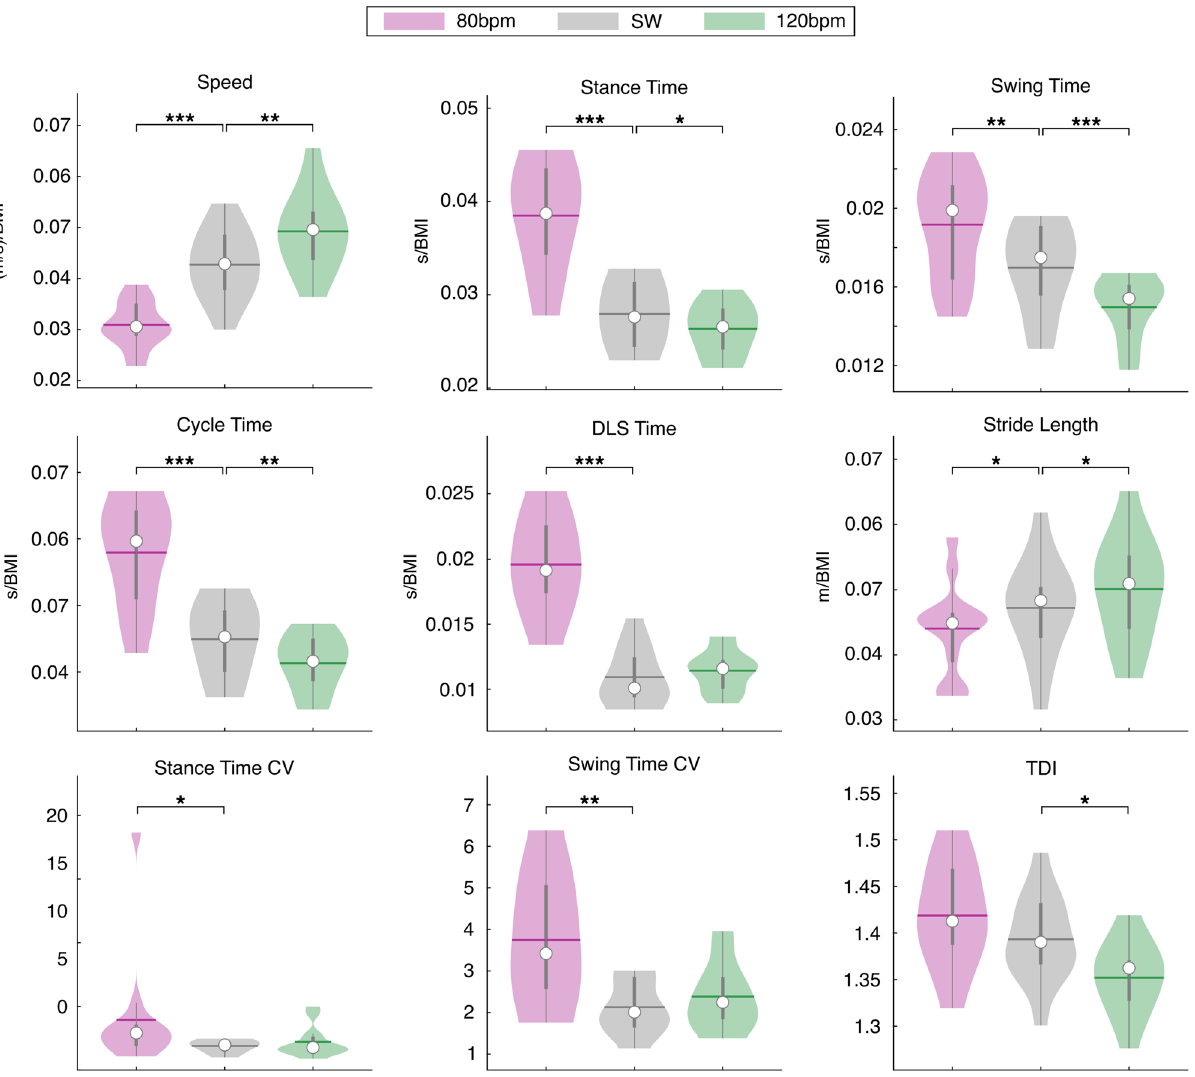
Figure 2. Spatiotemporal analysis of gait and Trunk Displacement Index (TDI). SW vs. RAS at variable frequencies. Violin plots of spatiotemporal parameters and TDI value. Comparison between simple walking (SW) and walking with RAS at variable frequencies based on the individual average cadence (AC) (SW; 90%- AC; 110%-AC; 100%-AC). DLS (double limb support). Significance p value: *p < 0.05, **p < 0.01, ***p <